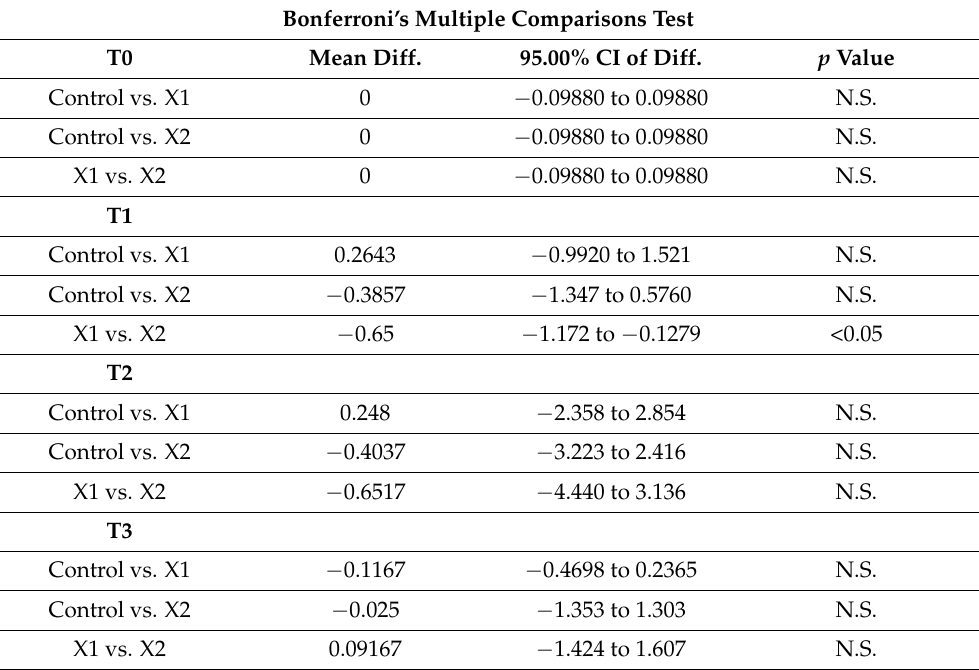
Table 1. Bonferroni’s post hoc multiple comparison results. N.S. = not significant.